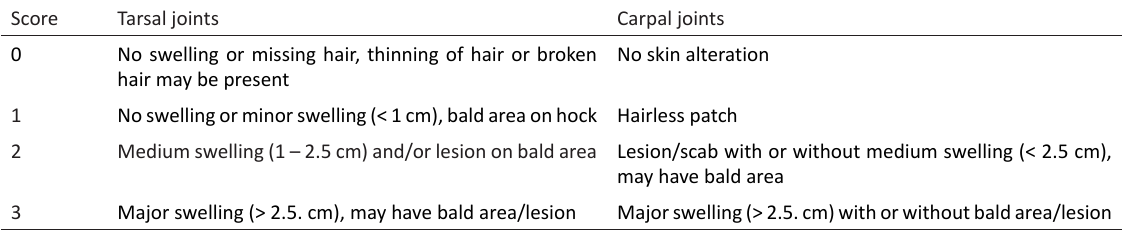
Table 1. Four point scale used to assess the condition of both the tarsal joints and the anterior surface of the carpal joints (Gibbons et al.